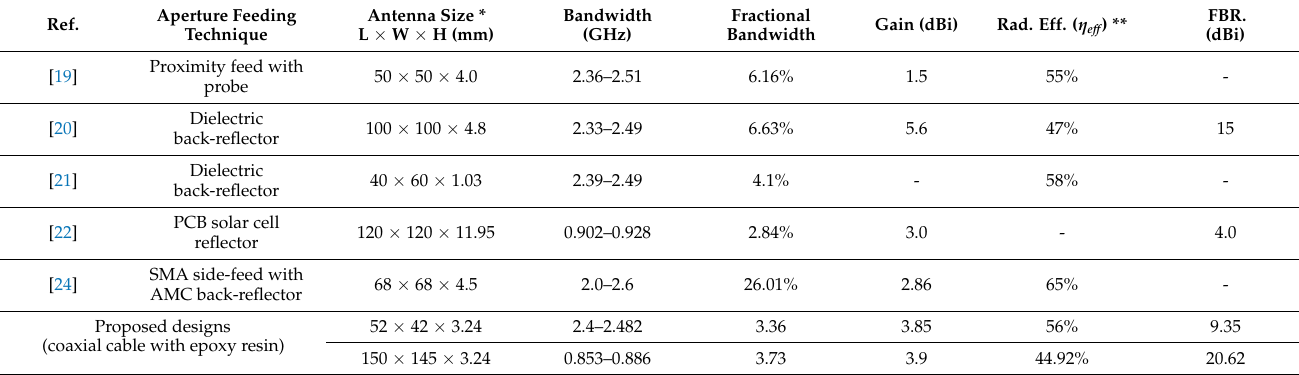
Table 3. Comparison of fabric-based patch antennas with aperture/proximity feeding